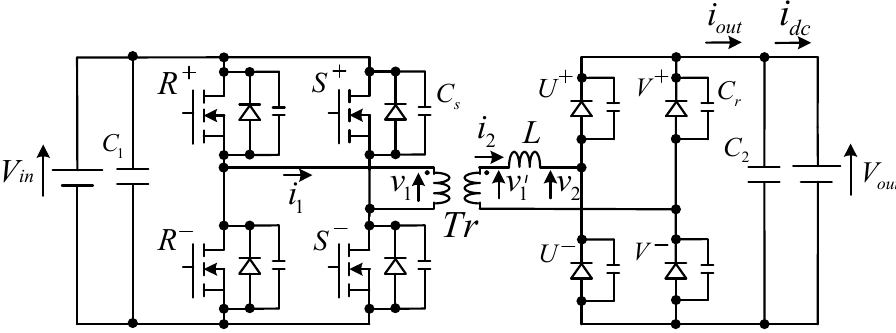
Figure 1. Proposed unidirectional secondary resonant single active bridge (SR–SAB) DC–DC con- verter circuit.